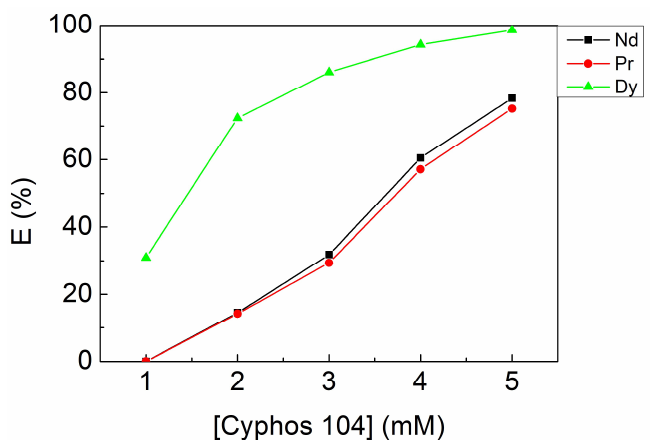
Figure 4. Extraction efficiencies at different Cyphos IL 104 concentrations. Fixed parameters: contacting time of 10 min, pH 3, O/A ratio of 1.